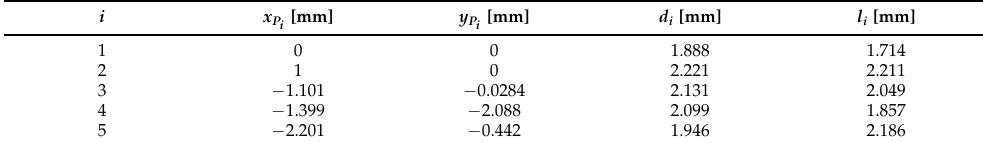
Table 4. All 12 possible solutions of the DKP for the 3-RR architecture in Table 1. Each solution is defined by the value of the unknown s 2,4 in the characteristic polynomial; from this value, the coordinates of points P i ( i is derived.